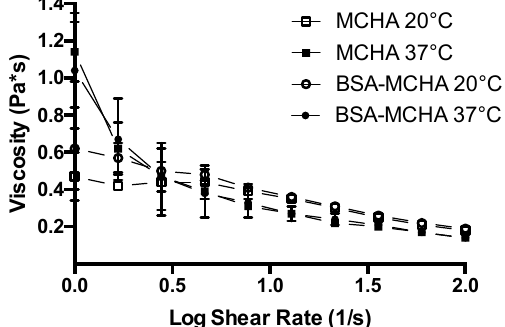
Figure 2. Rheological properties of the methylcellulose (MC)-hyaluronic acid (HA) hydrogels (MCHA) at 20 and 37 °C, with or without fluorescein isothiocyanate-labeled bovine serum albumin at 0.2% w / v (BSA-MCHA). Data represent means ± SD ( n = 3).